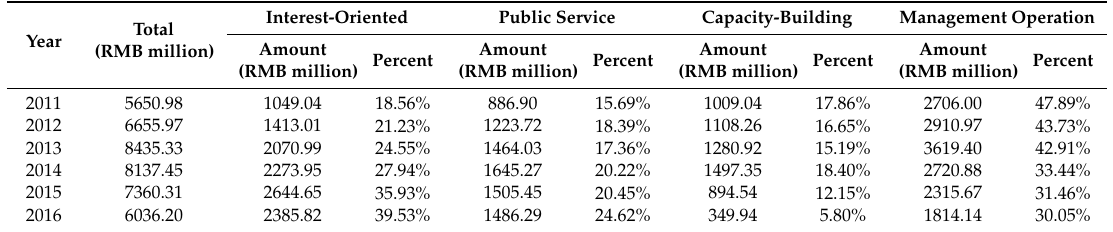
Table 3. 2011–2015 Classification and Structure of Family Planning Expenditure in Shandong Province.